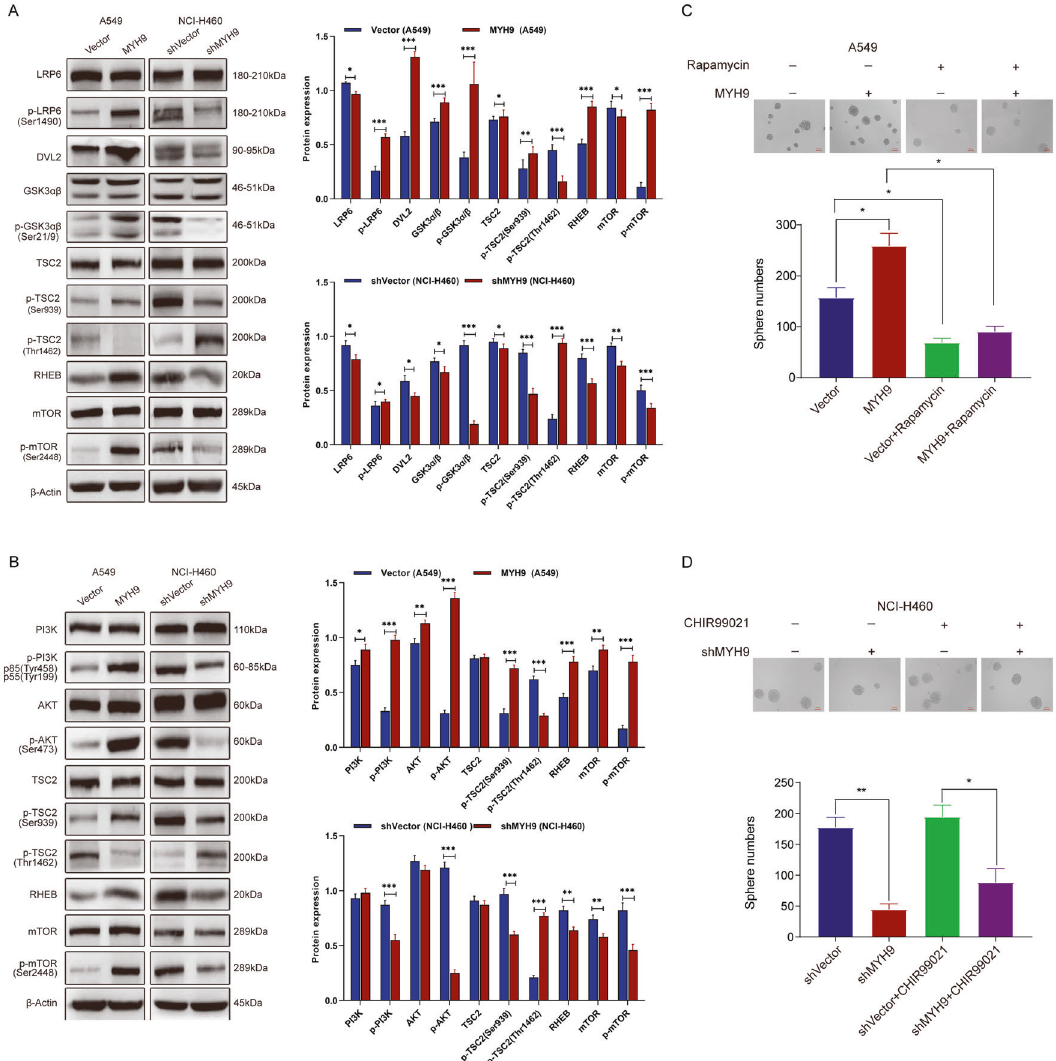
Fig. 5 MYH9 regulates the stem phenotype of LCCs by activating the mTOR signaling pathway. A The protein expression of LRP6/GSK3/ mTOR signal pathway markers in MYH9 stable transformant and control cells. B The expression of proteins from PI3K/AKT/mTOR signaling pathway in MYH9 stable transgenic and control cells. C Analysis of the effect of mTOR inhibitor Rapamycin on the self-renewal ability of MYH9 overexpressing cells and control cells (scale bar, 100 μ m; n = 3; * p < 0.05; n.s., not signi fi cant; Student ’ s t -test). D The effect of GSK3 inhibitor CHIR – 99021 on MYH9 low expression cell self-renewal ability and control cells (scale bar, 100 μ m; n = 3; * p < 0.05and ** p < 0.01; Student ’ s t